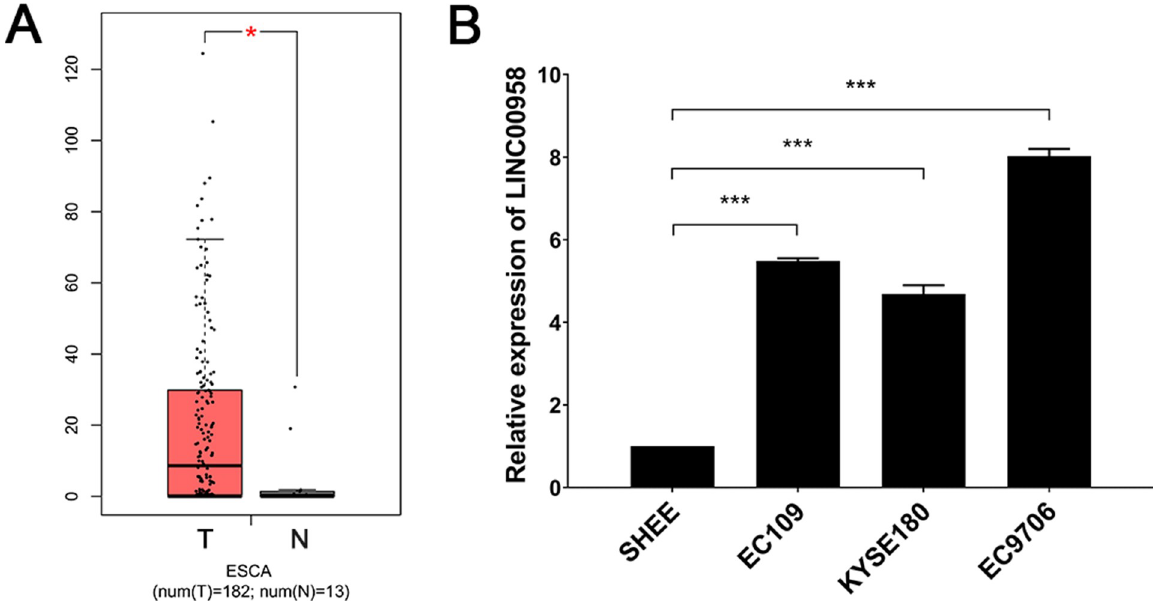
Fig 1. Expression of LINC00958 in ESCC cell lines and tissues. (A) The mean expression of LINC00958 in ESCA patients (GEPIA). The mRNA expression of pattern of LINC00958 in 182 ESCA tumour tissues (T) and 13 normal tissues (N) ( � P < 0.05). (B) The RT-qPCR detection of LINC00958 in ESCC cells ( ��� P < 0.001, n =